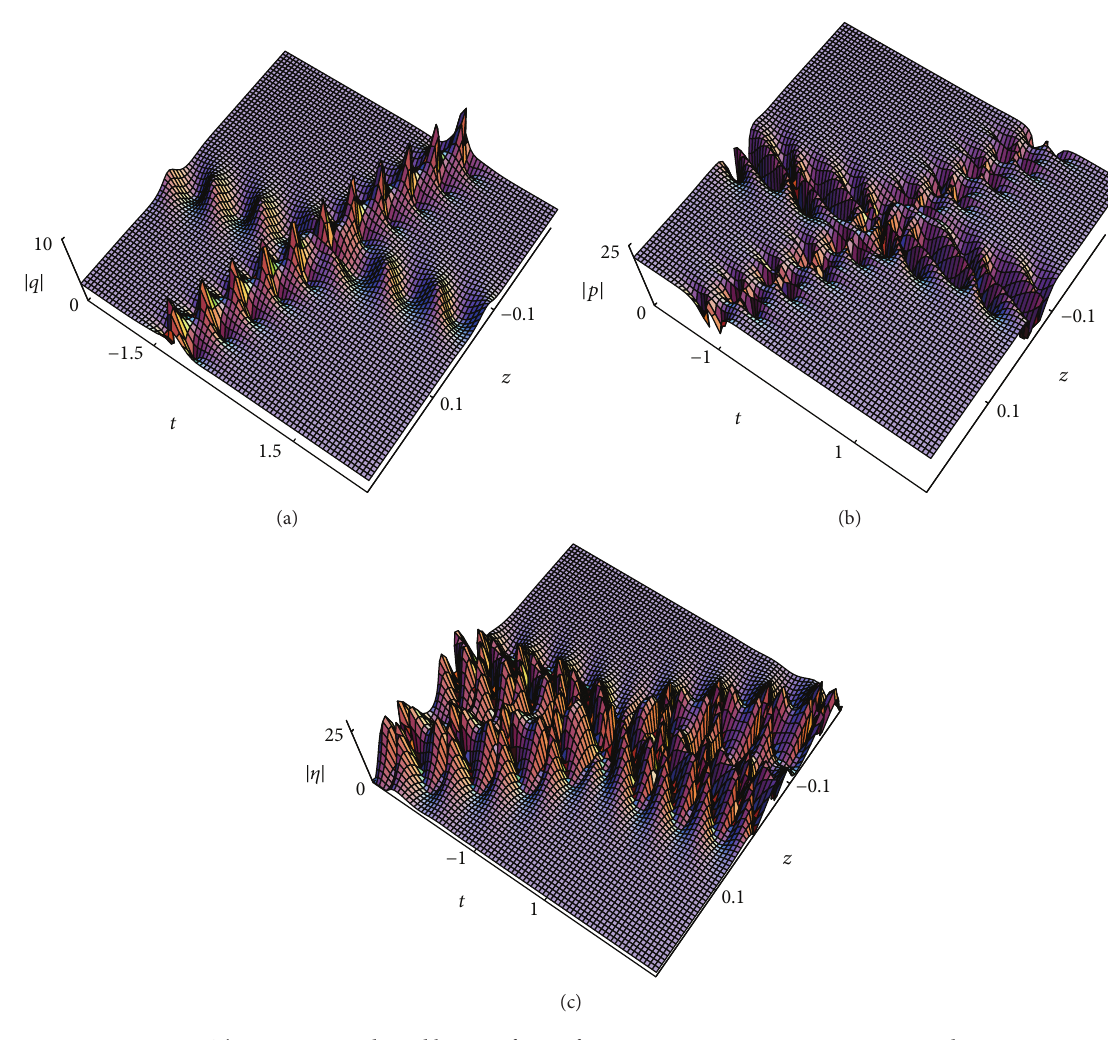
Figure 8: The parameters adopted here are 𝜆 1 = 𝑖 , 𝜆 2 = 2𝑖 , 𝑞 𝑐 = 3 , 𝜔 𝑐 = 2 , 𝜅 𝑐 = 1 , 𝜔 = 0.5 , and 𝜏 = 0.1 .